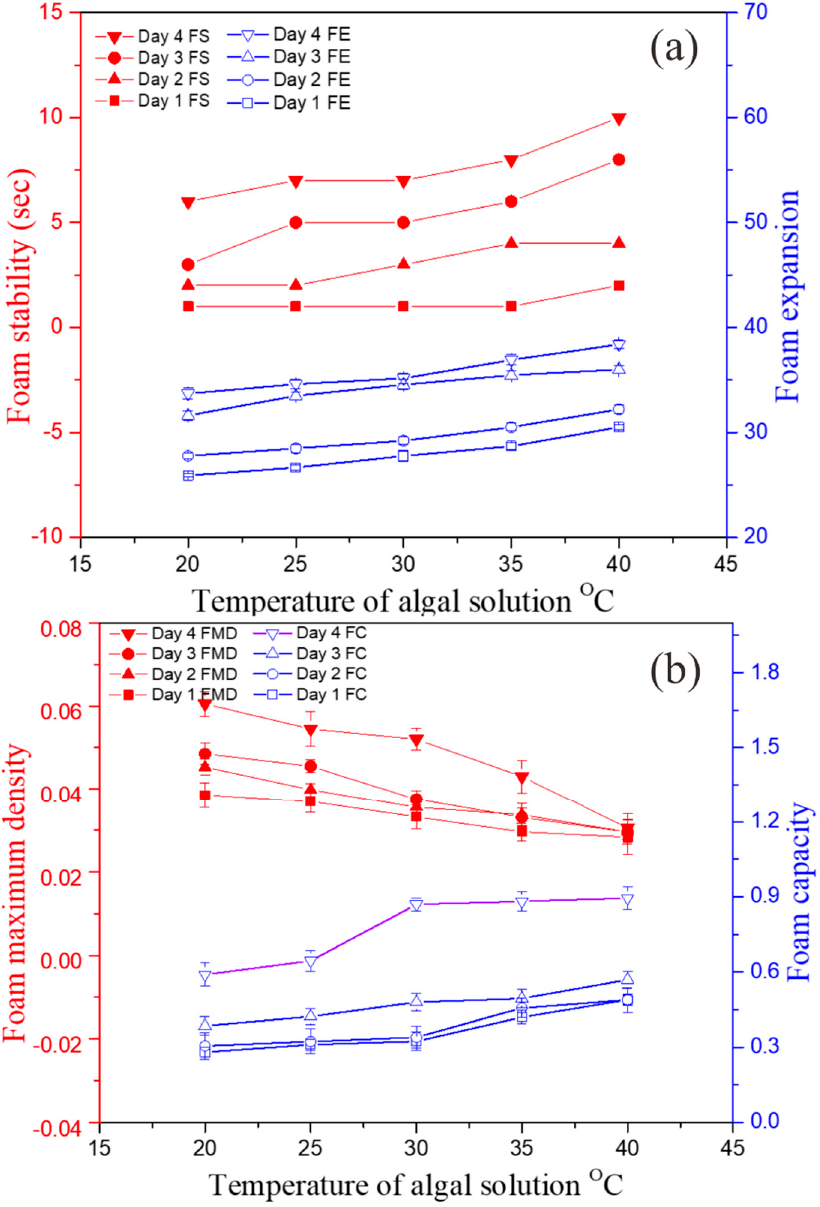
Figure 8. Effects of temperatures on dynamic characteristics: ( a ) foam stability and expansion and ( b ) foam maximum density and capacity.